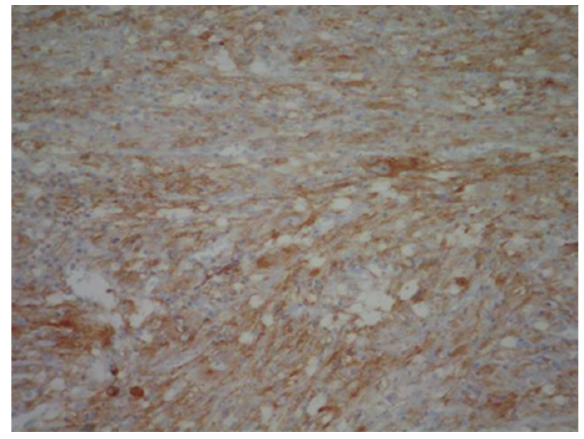
Figure 5: (ALK-1, 200x): Positive stain for ALK protein at